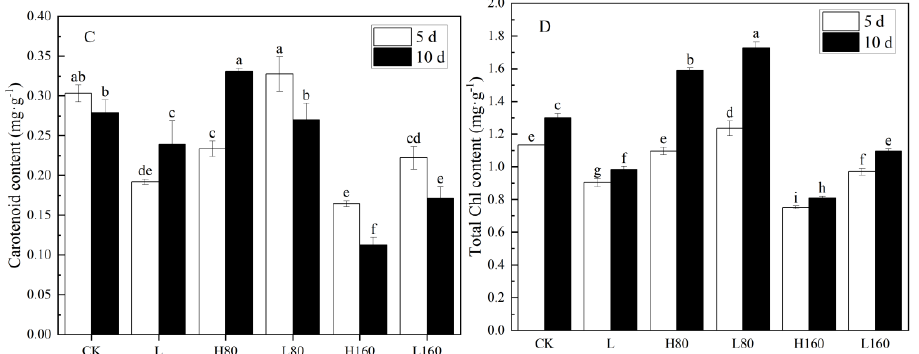
Figure 1. Effects of low R:FR ratio on content of Chl a, Chl b, carotenoid and total Chl of pakchoi with excessive nitrate stress. ( A ): Chl a content; ( B ): Chl b content; ( C ): Carotenoid content; ( D ): Total Chl content. The values shown are means ± standard deviations ( n = 3). Different letters mean marked differences at p < 0.05 based on Duncan’s multiple range test. 0 d: on day 0 after treatment; 5 d: on the fifth day after treatment; 10 d: on the tenth after treatment. CK: white light (R:FR = 4.2); L: white light and far-red light, R:FR = 0.7; H80: additional 80 mmol·L − 1 NO 3 − was added, R:FR = 4.2; L80: additional 80 mmol·L − 1 NO 3 − was added, R:FR = 0.7; H160: additional 160 mmol·L − 1 NO 3 − was added, R:FR = 4.2; L160: additional 160 mmol·L − 1 NO 3 − was added, R:FR = 0.7. This is similar hereinafter.